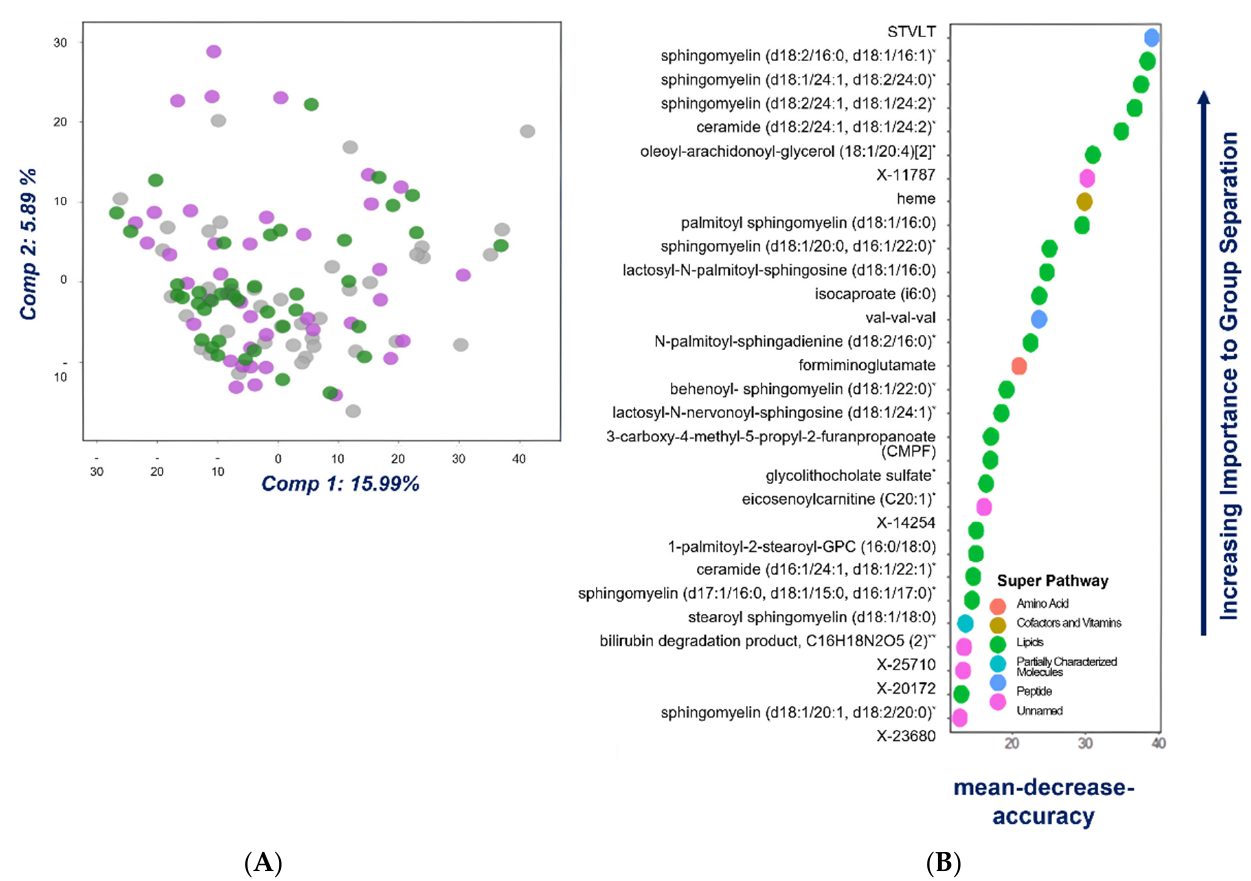
Figure 1. Two-dimensional principal component analysis plot for all fecal samples color-coded by group (grey—control group; purple—AA; and green—CRC) ( A ). Top 30 metabolites’ biochemical importance plot performed by RF classification-method analysis for control + AA vs. CRC. The plot shows each variable on the Y-axis and their importance on the X-axis ( B ). * indicates the compound has not been confirmed based on standard, but highly confident on its identification, and ** standard was not available and reasonably confident on its